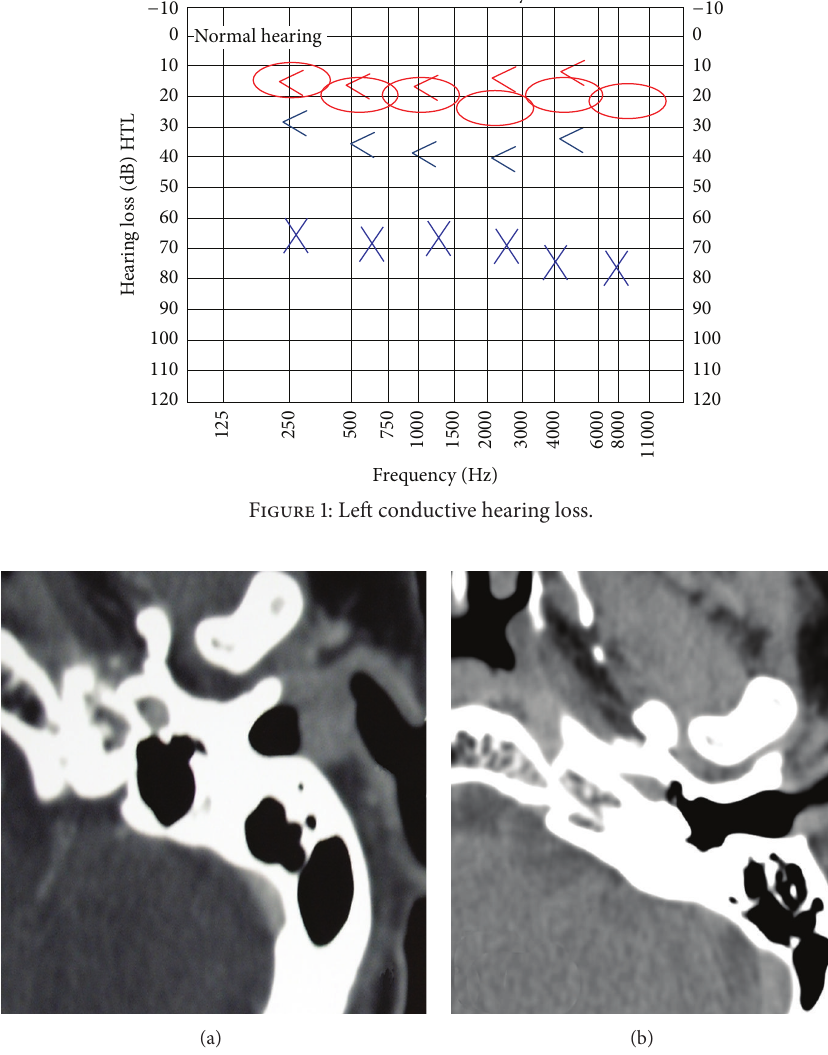
Figure 2: Petrous bone CT before (a) and after (b) the excisional